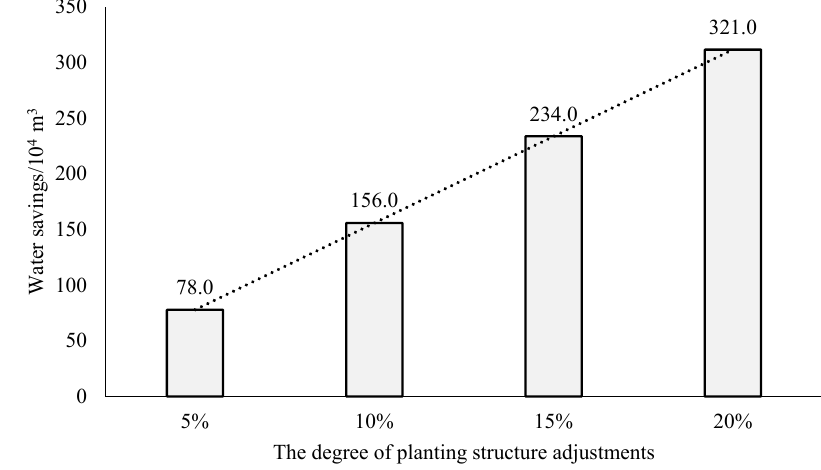
Figure 11. Water savings of different planting structure adjustments.